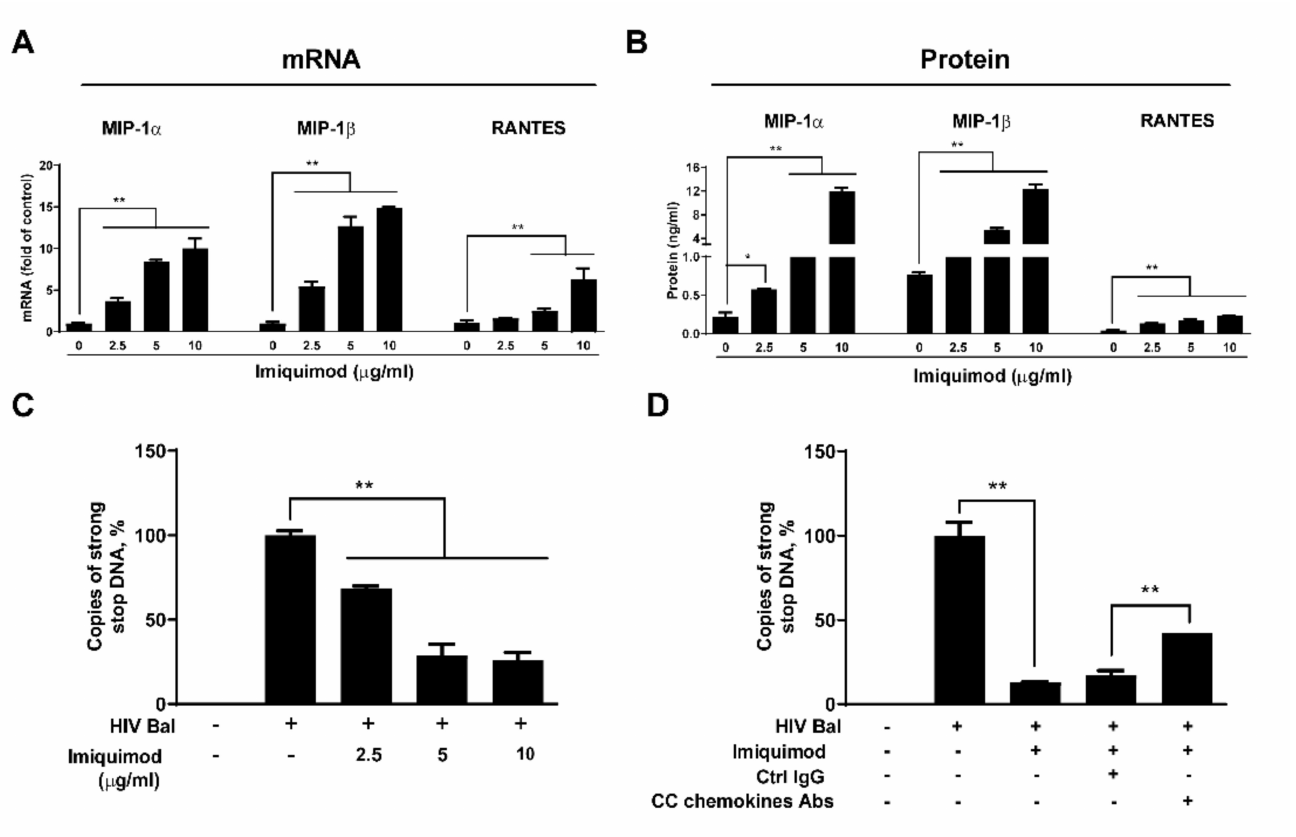
Figure 5. Imiquimod induces CC chemokines. ( A , B ) Macrophages were treated with or without imiquimod at the indicated concentrations. Total cellular RNA was extracted at 6 h post-treatment and subjected to the real-time PCR for the mRNA levels of MIP-1 α , MIP-1 β , RANTES, and GAPDH ( A ). Twenty-four hours after imiquimod treatment, culture supernatant was then collected and subjected to the ELISA assay for the protein levels of MIP-1 α , MIP-1 β , and RANTES ( B ). ( C ) HIV strong-stop DNA was detected in macrophages pretreated with imiquimod at the indicated concentrations. ( D ) Macrophages were pretreated with imiquimod (10 µ g/mL) for 24 h and then were incubated with 20 µ g/mL control IgG or a mixture of neutralization antibodies to MIP-1 α , MIP-1 β , and RANTES for 2 h prior to infection with HIV Bal which had been treated with RNase Free DNase I. HIV strong-stop DNA was quantified at 3 h post-infection. Data are shown as mean ± SD of three independent experiments (* p < 0.05, ** p <